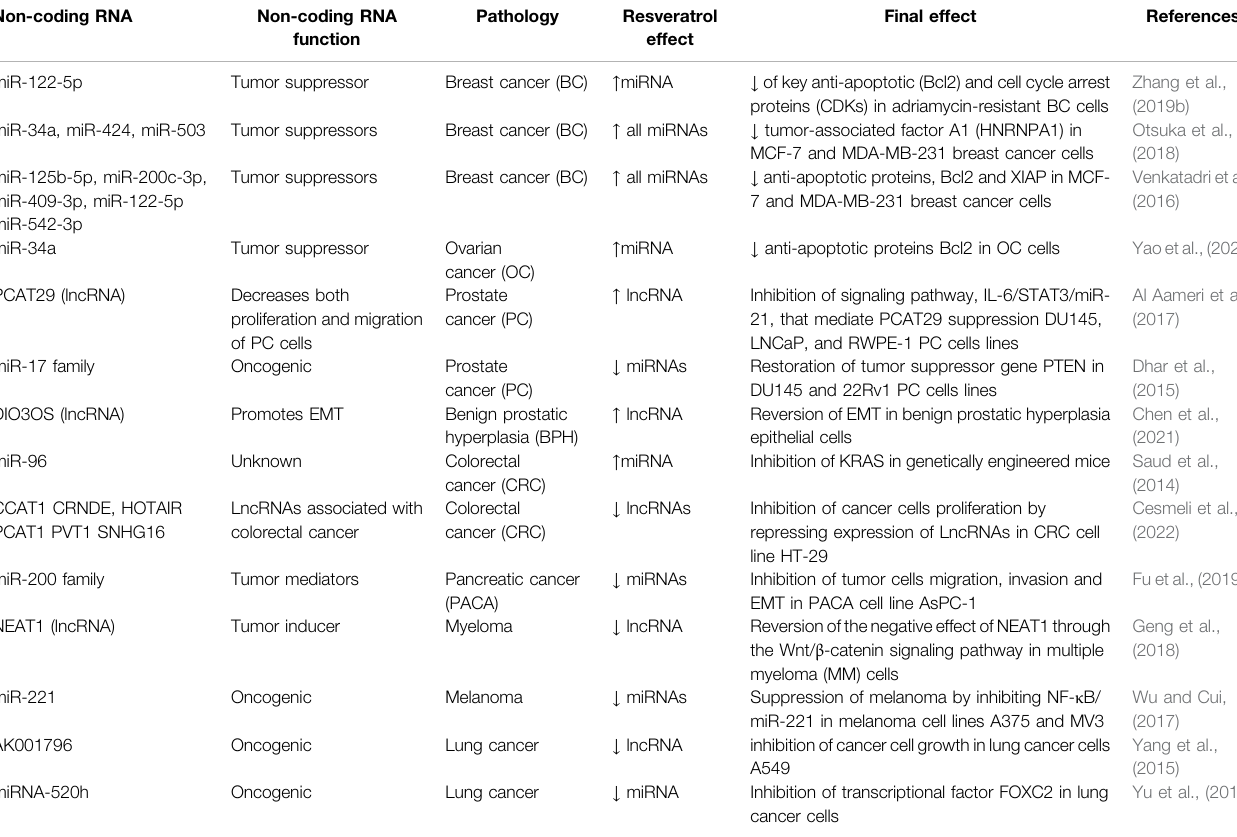
TABLE 4 | Cancer Non-coding